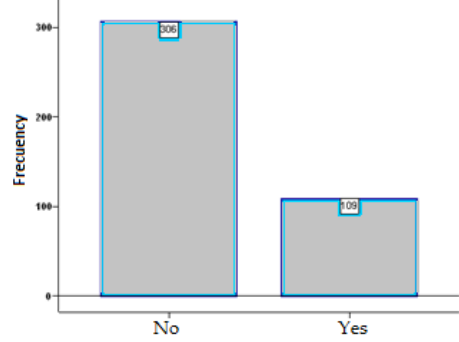
Figure 2. Does the fear of falling limit your